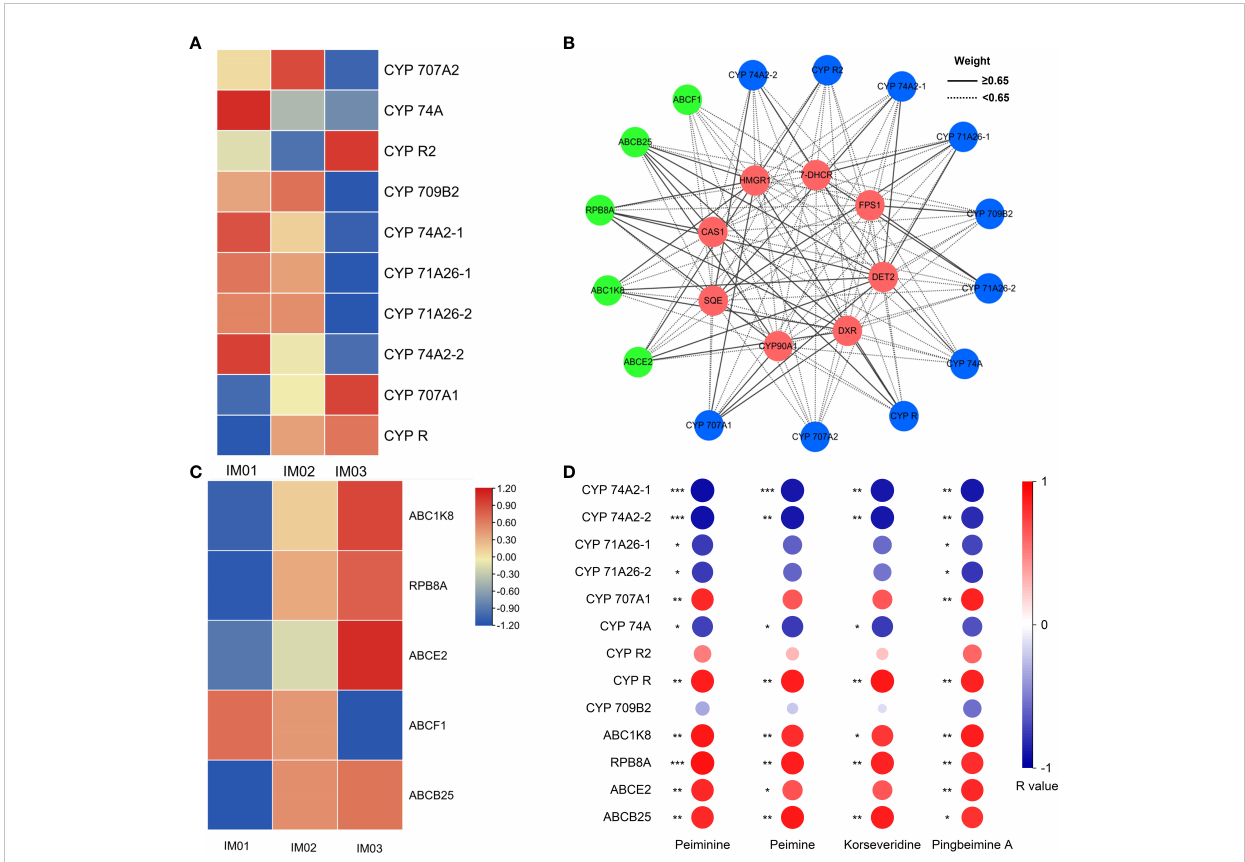
FIGURE 7 CYP, and ABC gene analysis. (A) . Heatmap of CYP genes in the MEturquoise module. (B) . Co-expression network analysis of eight candidate genes, CYP, and ABC transporter genes in the MEturquoise module. The lines represent the weighted Pearson ’ s correlation coef fi cients. Green, blue, and red denote ABC transporters, CYPs, and candidate genes, respectively. (C) . Heatmap of genes encoding ABC transporters in the MEturquoise module. (D) . Heatmap of CYP and ABC transporter genes with weighted Pearson ’ s correlation coef fi cient values ≥ 6.5 and steroidal alkaloids related to the MEturquoise module, r ’ s value were calculated (* p <0.05; ** p <0.01; *** p